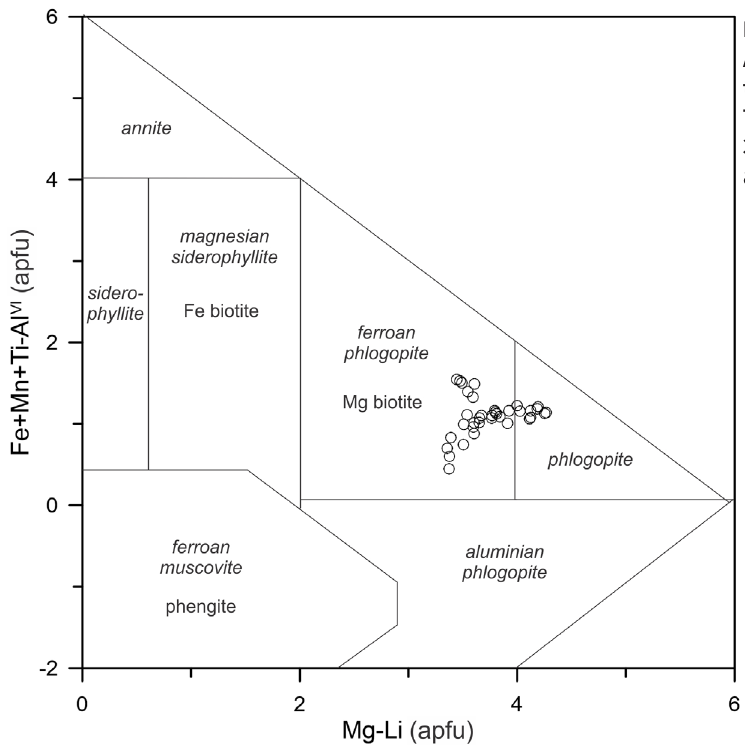
Figure 6. Octahedral Fe +Mn+Ti- tot Al VI versus octahedral Mg-Li for trioctahedral micas. Adapted from Tischendorf et al. (2001). Result of 36 spots analyzed by EPMA. IMA approved nomenclature is in